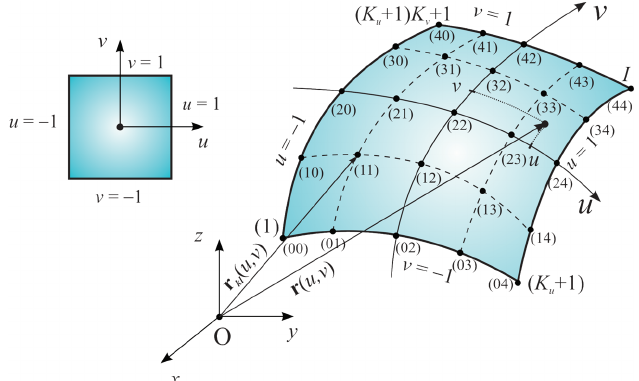
Figure 11. Generalized curved parametric quadrilateral patch, with r ( u , v ) defined in Equation (1) and the square parent domain also shown, for higher order MoM-SIE modeling of winter precipitation particles. Element currents are modeled by polynomial basis functions of arbitrary orders, as in Equation (1).